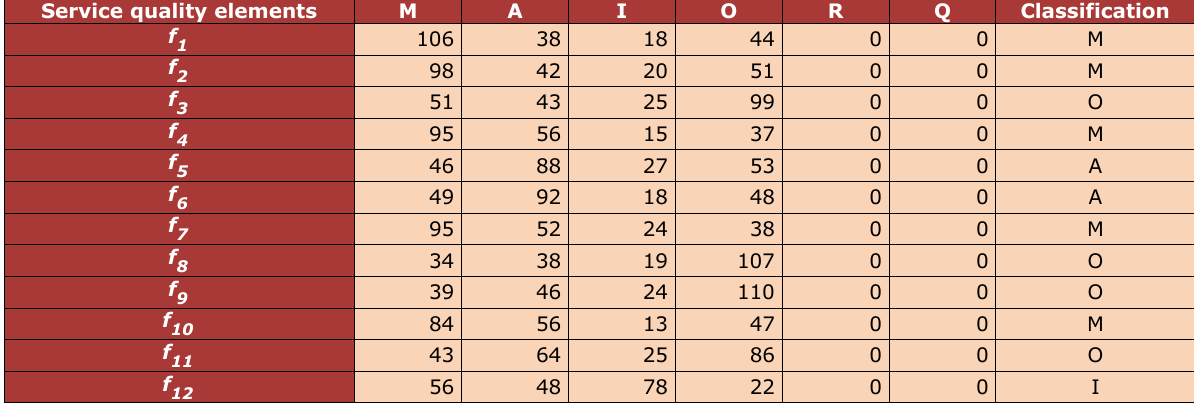
Table 7. Classification of service quality elements when α=0.4